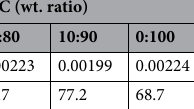
Table 3. Crystallite size ( t ) of PTB7-Th: ITIC blends at 2 θ ≈ 21.3 ◦